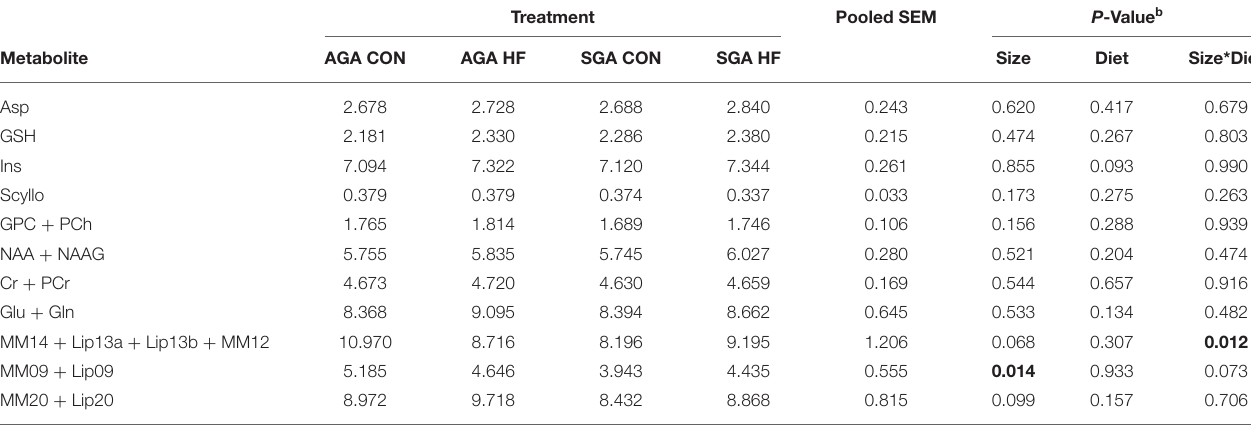
TABLE 4 | Effects of birth weight and HF on hippocampal metabolism as determined by single-voxel spectroscopy in 4 week-old piglets a